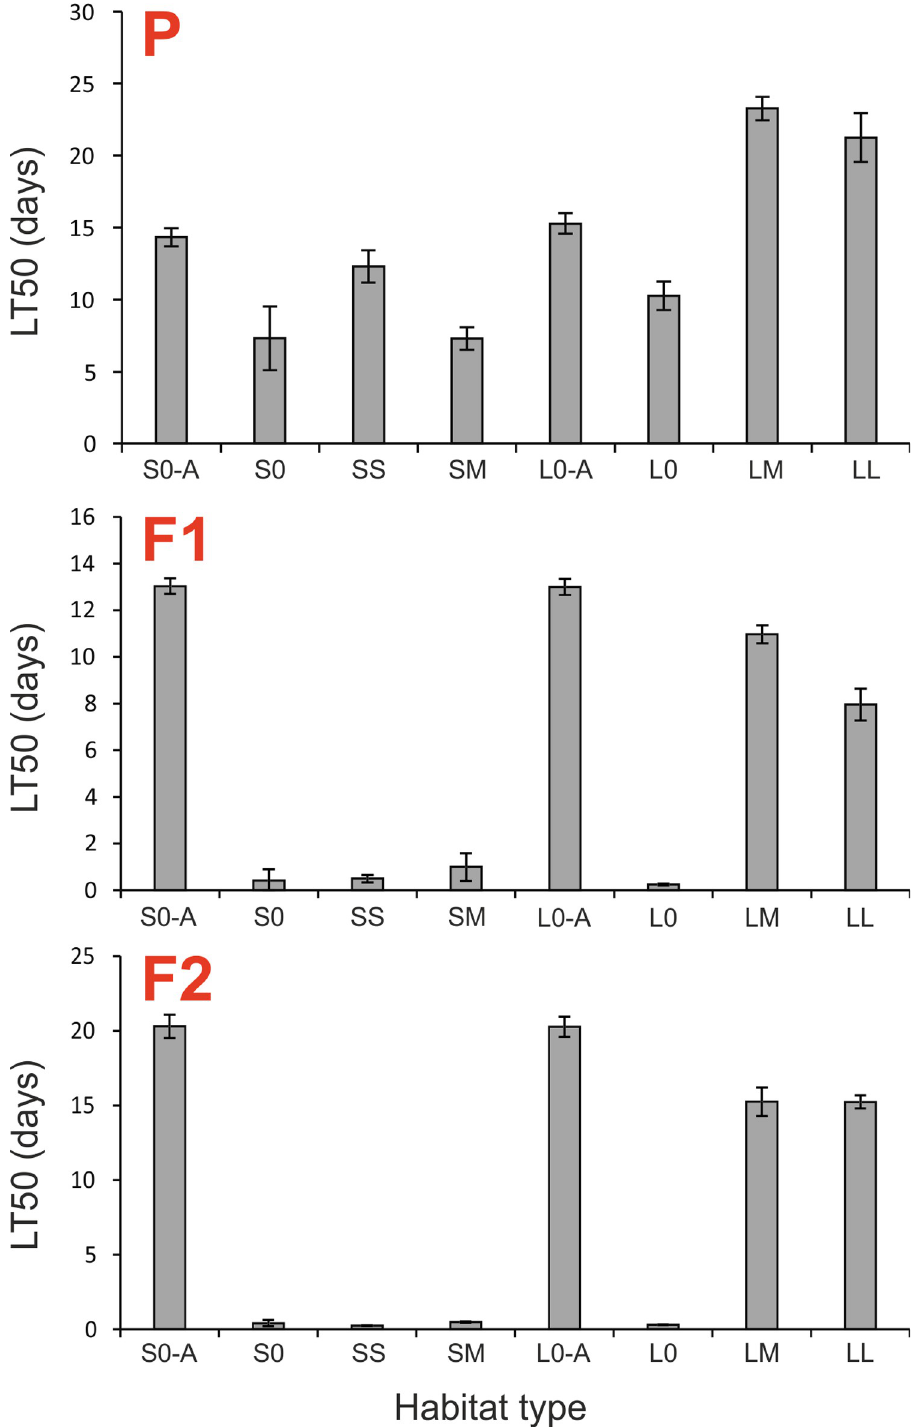
Fig 4. Median lethal times (LT50s) with standard errors for the three generations of Poecilus cupreus from all experimental groups, representing different habitat types, landscapes and treatments. The first character stands for landscape type (S–small fields landscape, L–large fields landscape); the second character for canola coverage (0 –none, S–small, 10–14%, M–medium, 20–52%, L–large, 80–98%). All groups except those marked with letter “A” were exposed to Proteus 110 OD insecticide. Red uppercase letters indicate generations: P–parental, F1 & F2 –laboratory breed.